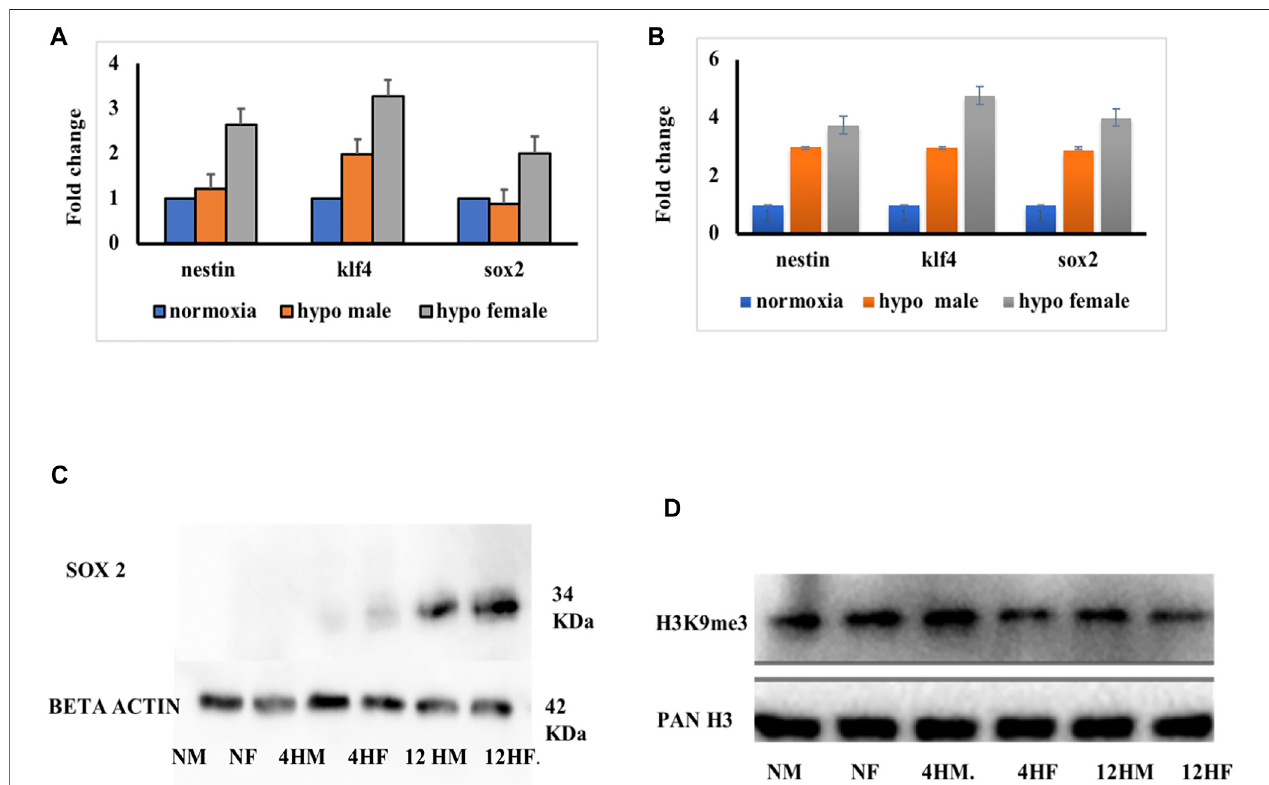
FIGURE 6 | Validation ChIP analysis. mRNA expression at 4 h (A) and 10 h (B) post hypoxia in both male and female ( n (cid:1) pooled 6 brain). Expression of sox2 protein at different times of recovery from hypoxia (C) . Expression of H3K9me3 at different times of recovery from hypoxia (D) .